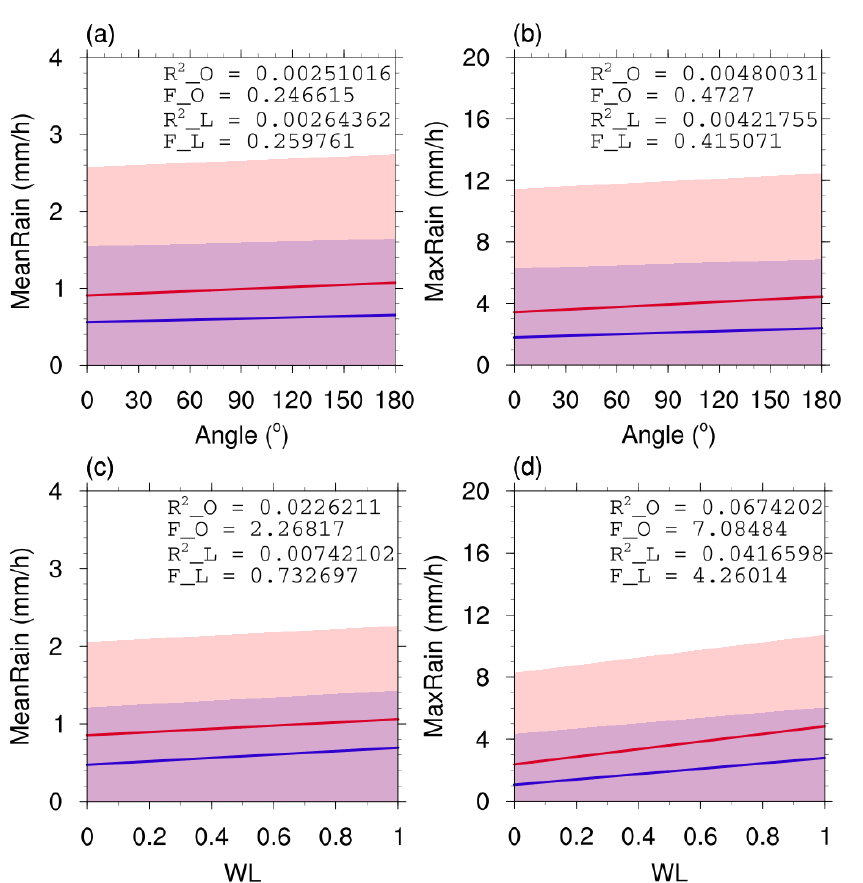
Figure 10. Relationship between the parameters of oceanic and continental rain clusters and the rain intensity: ( a ) rotation angle and the mean rain rate, ( b ) rotation angle and the maximum rain rate, ( c ) WL and the mean rain rate and ( d ) WL and the maximum rain rate. The blue and red lines represent the regression line of oceanic and continental rain clusters, respectively, and the blue- and red-shaded areas represent the 95% prediction intervals of oceanic and continental rain clusters, respectively. R2_O and F_O represent the R 2 and F values of the oceanic regression line; R2_L and F_L are the R 2 and F values of the continental regression line.